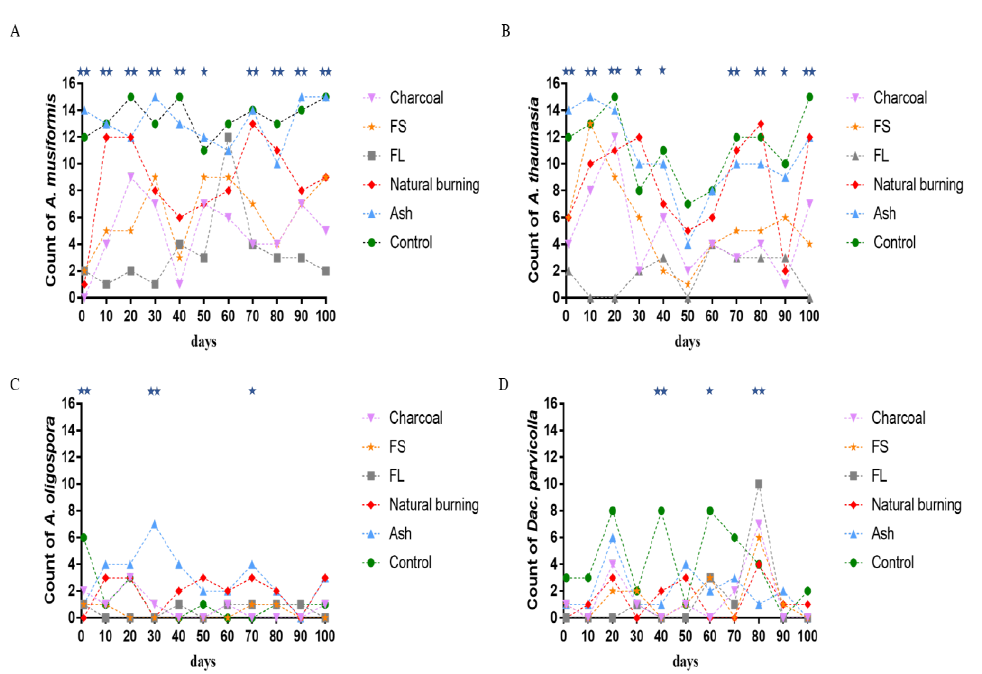
Figure 4. Dynamic of the counts of the widely distributed species in each treatment and difference among treatments. A: A. musiformis ; B: A. thaumasia ; C: A. oligospora ; D: Dac. parvicolla . ★ : p < 0.05; ★★ : p < 0.01. FS: treated with flame gun and the burn duration was 20 min; FL: treated with flame gun and the burn duration was 60 min; Charcoal: treated with charcoal; Ash: treated with cooled ash; Natural burning: treated with dry pine needles placed directly on the soil and let burn naturally and ashes were left on the soil after burn; Control: without any